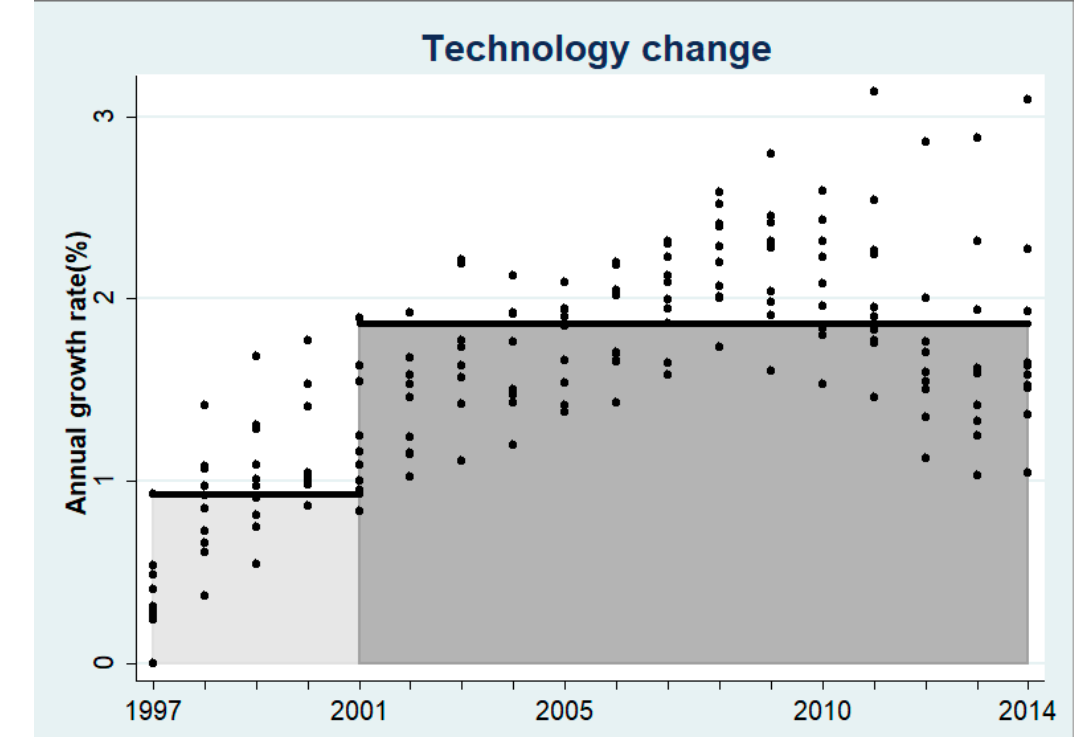
Figure 2. Technology change of cotton before and after Bt cotton adoption.